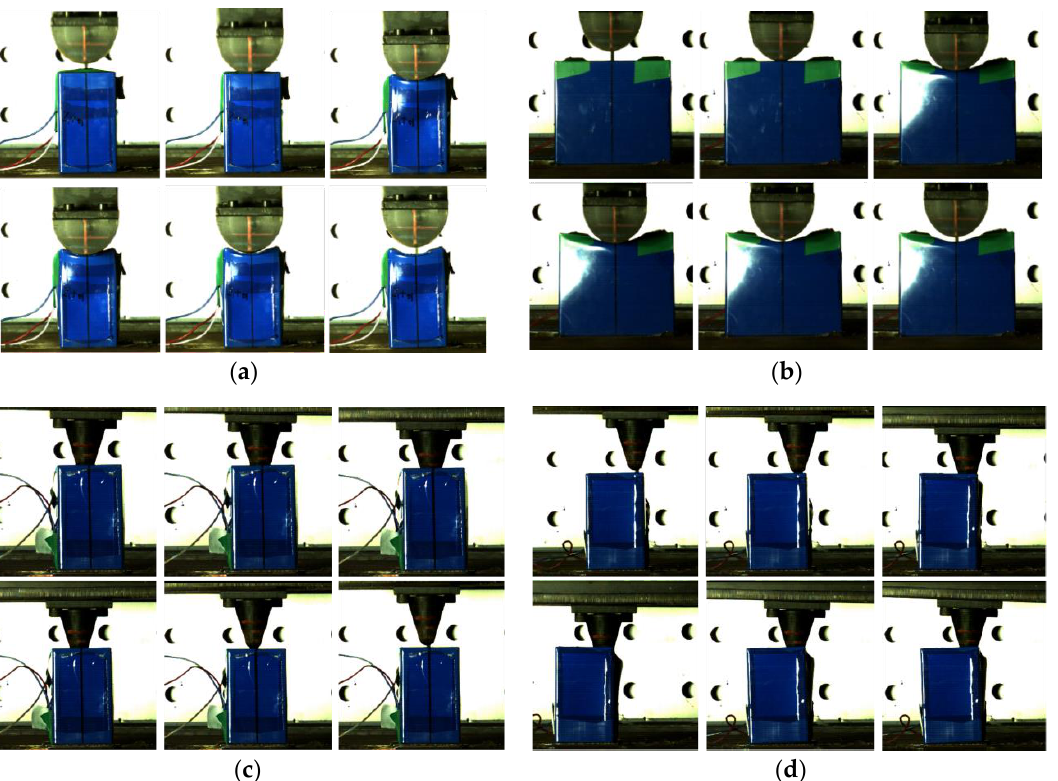
Figure 9. The dynamic impact process with different intenders. ( a ) Test process in the Z1+ orientation; ( b ) Test process in the Z2+ orientation; ( c ) Test process at the Z3− position; ( d ) Test process at the Z4− position.